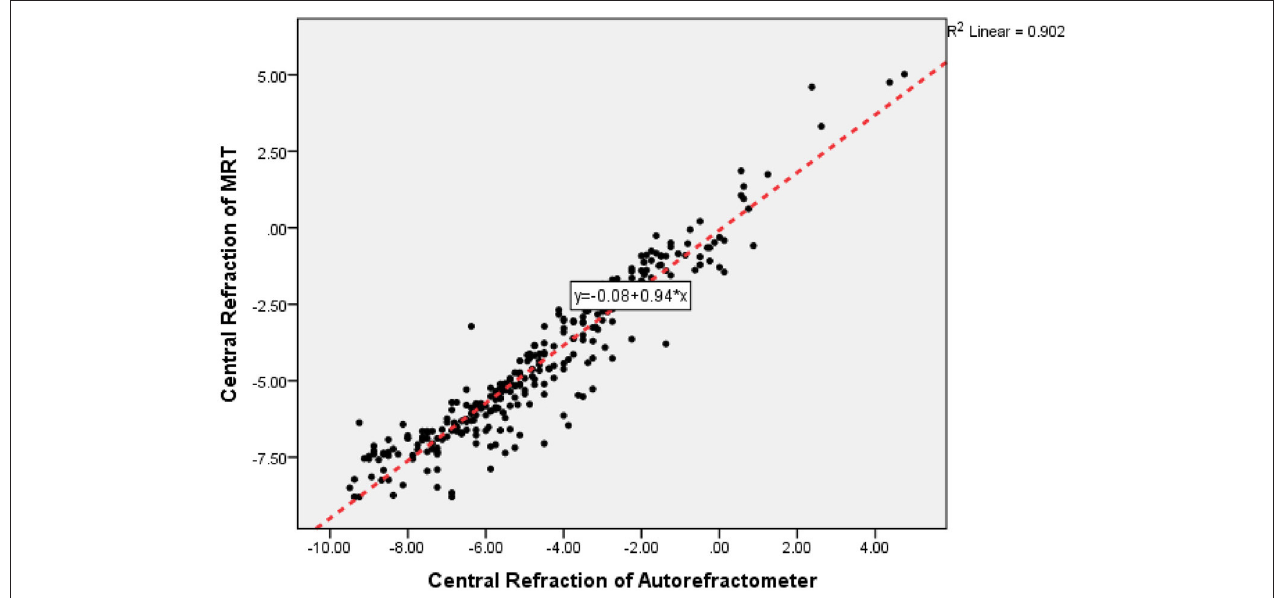
FIGURE 2 | The correlations of central refraction between multispectral refraction topography (MRT) and autorefractometer.